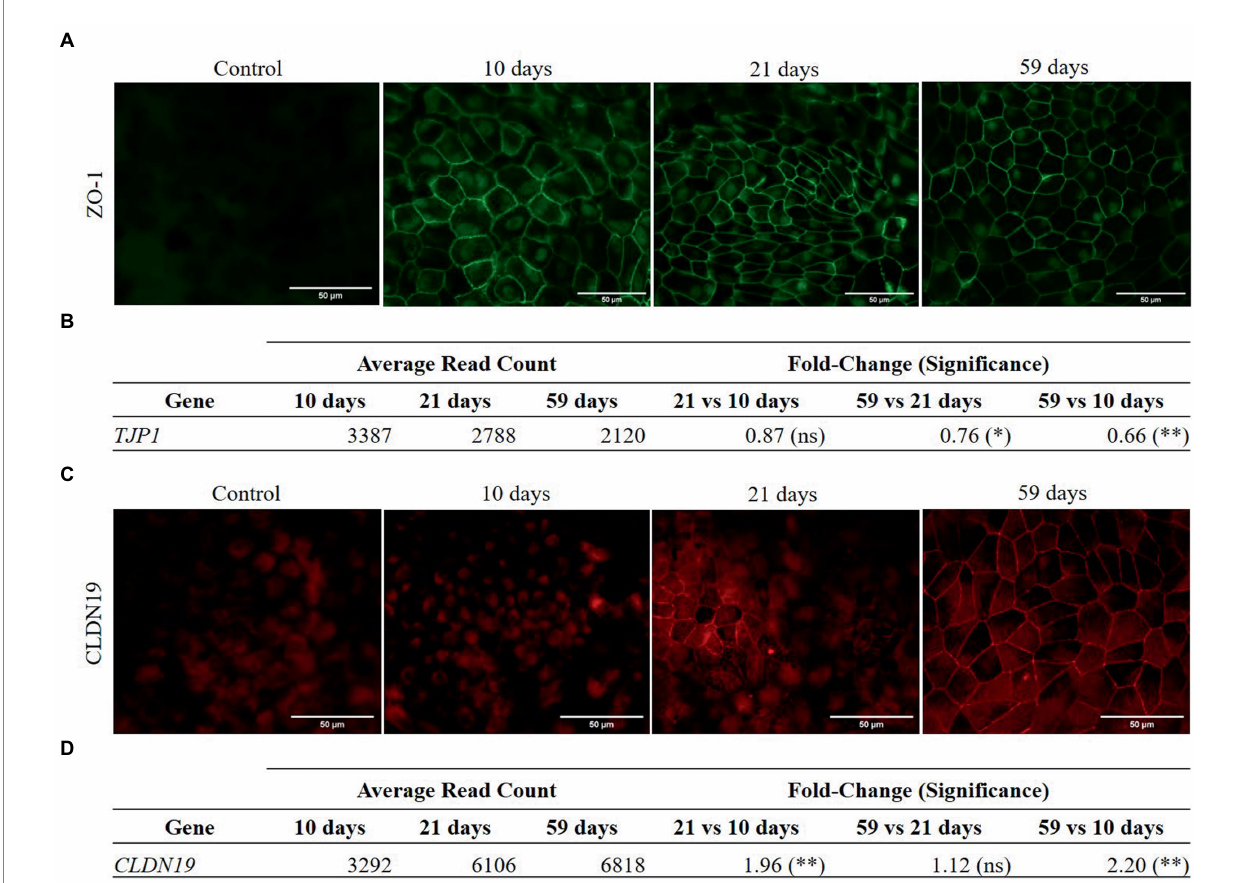
FIGURE 2 Protein immunolocalization and RNA expression of ZO-1 (A–B) and CLDN19 (C–D) in RPE cells. Differential gene expression analysis was carried out following the DESeq2 method (ns: q -value >0.05; *: q-value <0.05; **: q-value <0.01). (A) ZO-1 is detected in the cell membranes of RPE cells at 10, 21 and 59 days in culture. (B) ZO-1 coding gene, TJP1, is significantly down-regulated at 59 days in culture compared to 21 and 10 days in culture. (C) CLDN19 is not detected at 10 days in culture but appears with increasing abundance in the cell membranes of RPE cells after 21 and 59 days. (D) Gene expression of CLDN19 significantly increased from 10 to 21 days in culture and from 10 to 59 days in